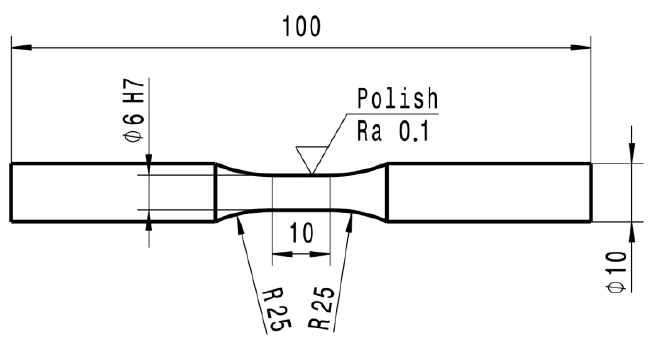
Figure 3. Sample drawing for fatigue testing acc. to standard EN 3987 (in mm) [35].